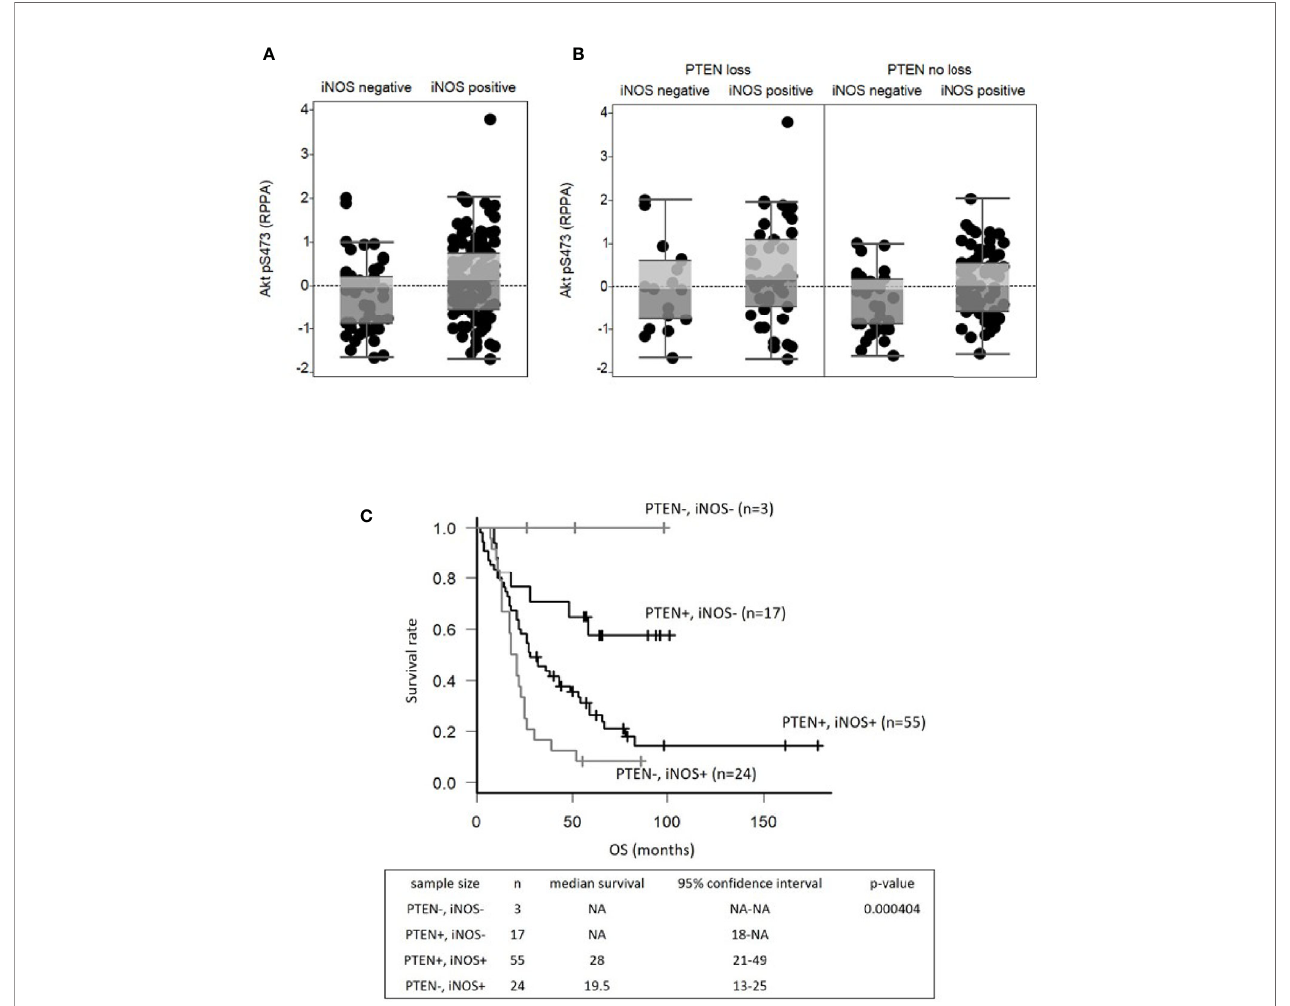
FIGURE 1 | iNOS expression is associated with increased AKT activity and poor clinical outcomes in melanomas with intact PTEN. Reverse phase protein array analyses show (A) expression levels of the phospho-AKT Ser 473 protein (pAKTS473) in iNOS-negative (<0.1 transcripts per kilobase million) and iNOS-positive ( ≥ 0.1 transcripts per kilobase million) tumors in the melanoma TCGA, and (B) pAKTS473 protein expression levels in iNOS-negative and iNOS-positive groups with PTEN loss (mutated PTEN or PTEN copy number < -0.5) and without PTEN loss. A P value <0.05 was considered statistically signi fi cant. (C) Kaplan-Meier survival analysis based on combined markers of PTEN and iNOS status in tumor cells in stage III melanoma patients. A P value <0.05 was considered statistically signi fi cant. OS, overall